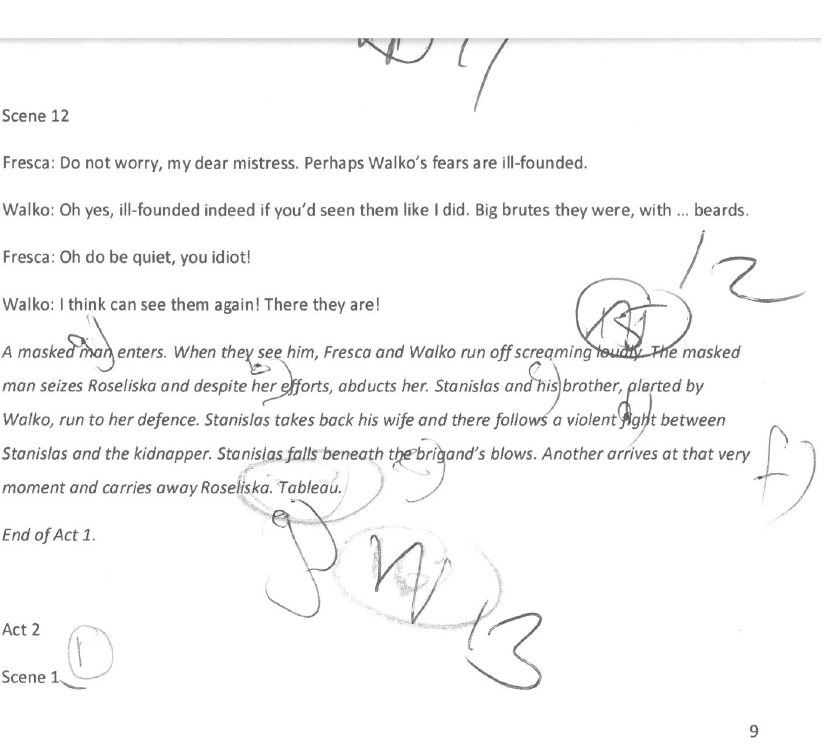
Fig. 2 Roseliska , end of act 1 . The musical director’s script from the 2017